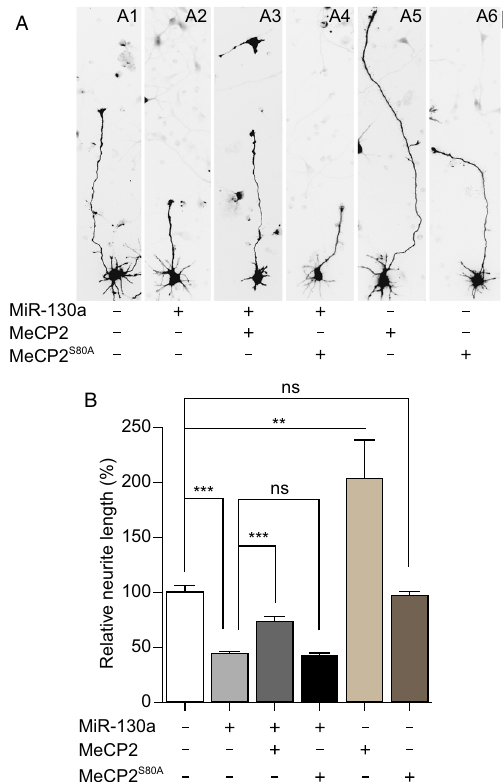
Figure 5. Expression of miR-130a decreases the length of neurites, a phenotype partially rescued by wild type MeCP2 but not by a loss-of-function MeCP2 mutant. (A) Rat E18 cortical neurons were electroporated with the vector control, miR-130a, MeCP2, MeCP2 S80A or miR-130a together with MeCP2 or MeCP2 S80A and cultured for 3 days before imaging. Scale bar: 25 μ m. (B) The average length of the longest neurites in (A) were measured and statistically analyzed from three independent experiments (mean values ± SEM; at least 100 neurons in each group were scored in each experiment). **, P < 0.01; ***, P < 0.001.